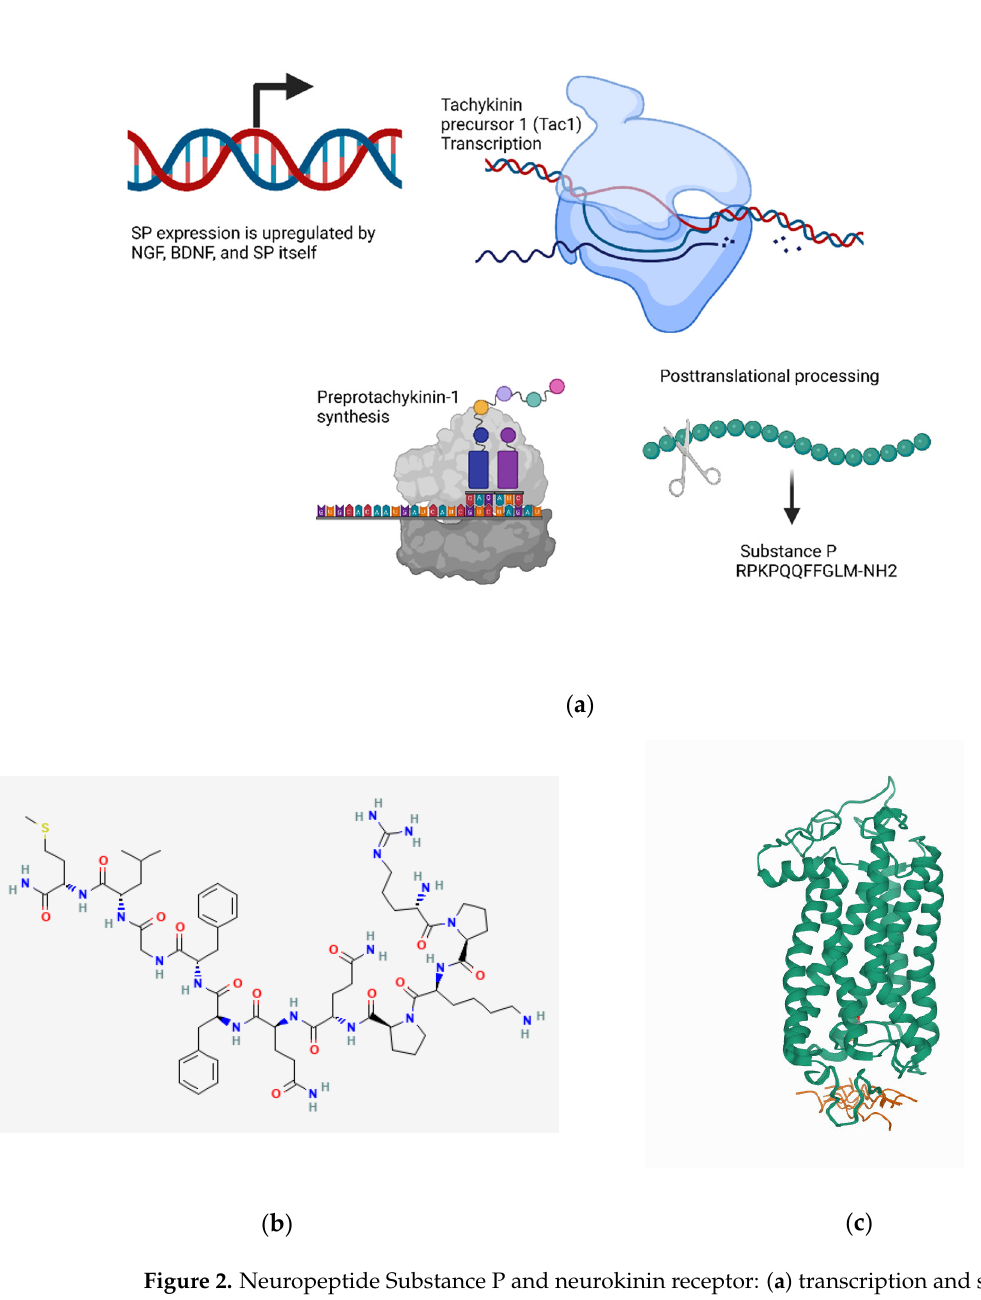
Figure 2. Neuropeptide Substance P and neurokinin receptor: ( a ) transcription and synthesis of SP (created with BioRender.com accessed on 22 October 2021); ( b ) 2D structure image of Substance P (https://pubchem.ncbi.nlm.nih.gov/compound/36511#section=2D-Structure, accessed on 22 October 2021); ( c ) bound-state structure representation of Substance P (brown) to NK1R (green). The solution conformation of Substance P in water was complexed with NK1R. Image from the RCSB PDB (rcsb.org) of PDB ID 2KS9 [73].